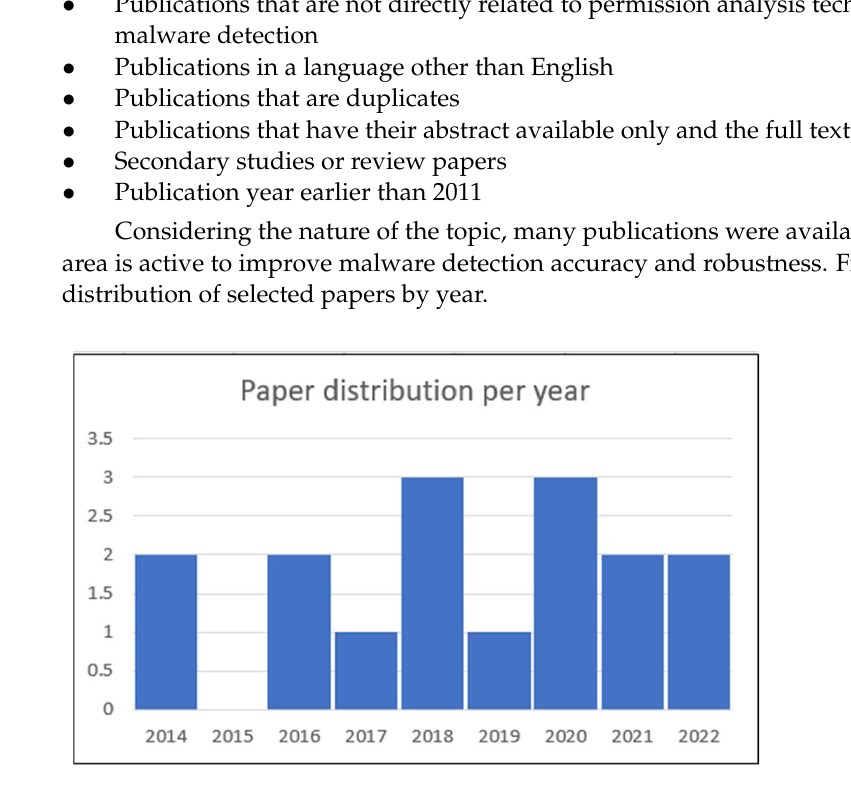
Figure 5. Publications’ distribution per year.